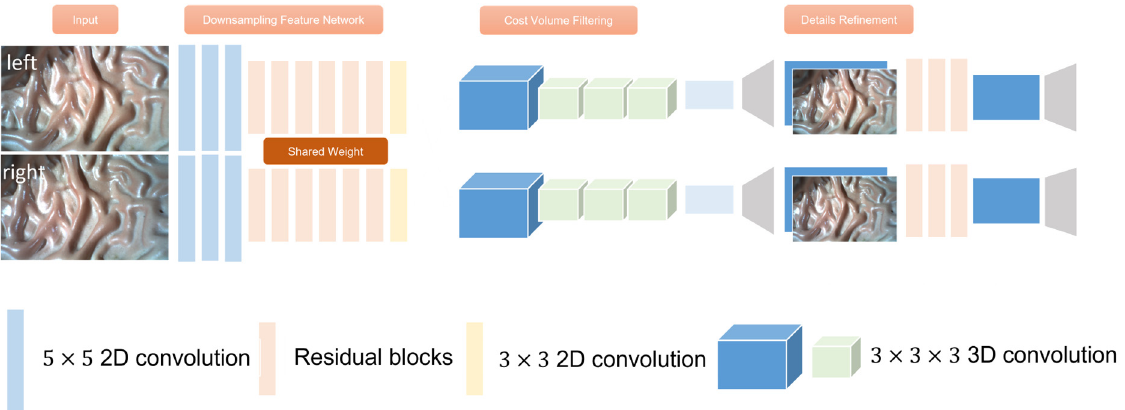
Figure 3. Network Structure of StereoNet.